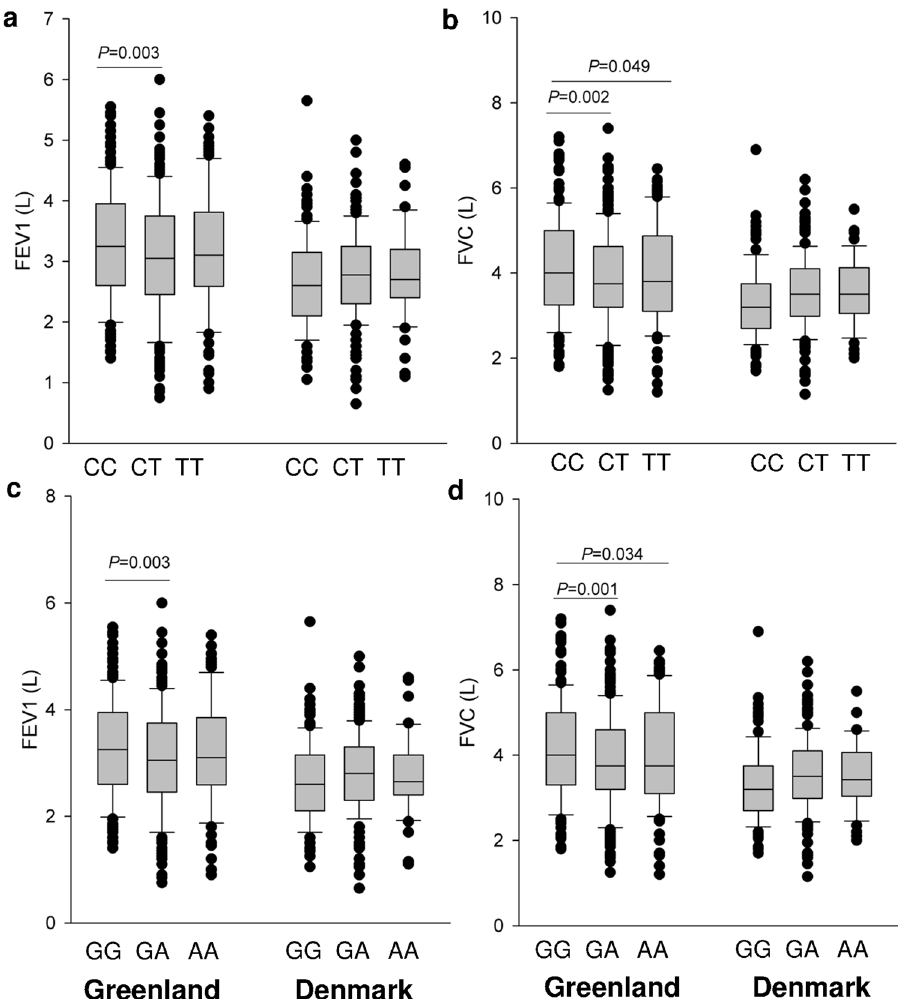
Figure 2. Associations of lung function and genotypes in the sensitivity analysis: Lung function (FEV1 and FVC) values in Greenlandic and Danish Inuit with full ethnicity were stratified by the genotypes of ORMDL3 SNPs rs12603332 ( a and b ) and rs4065275 ( c and d ). P values were adjusted for age, gender, height, and smoking. Box and whisker plots represent median with 10th and 90th